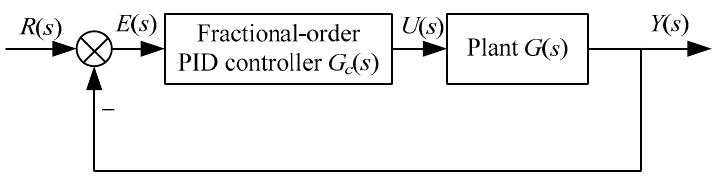
Figure 1. Block diagram of a closed-loop control system with a FOPID controller.